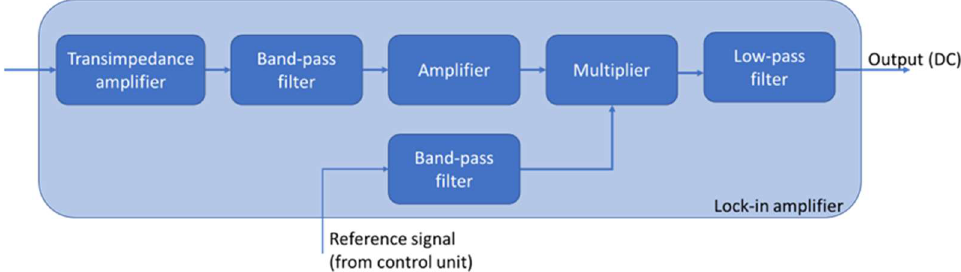
Figure 12. Lock-in amplifier functional block diagram.